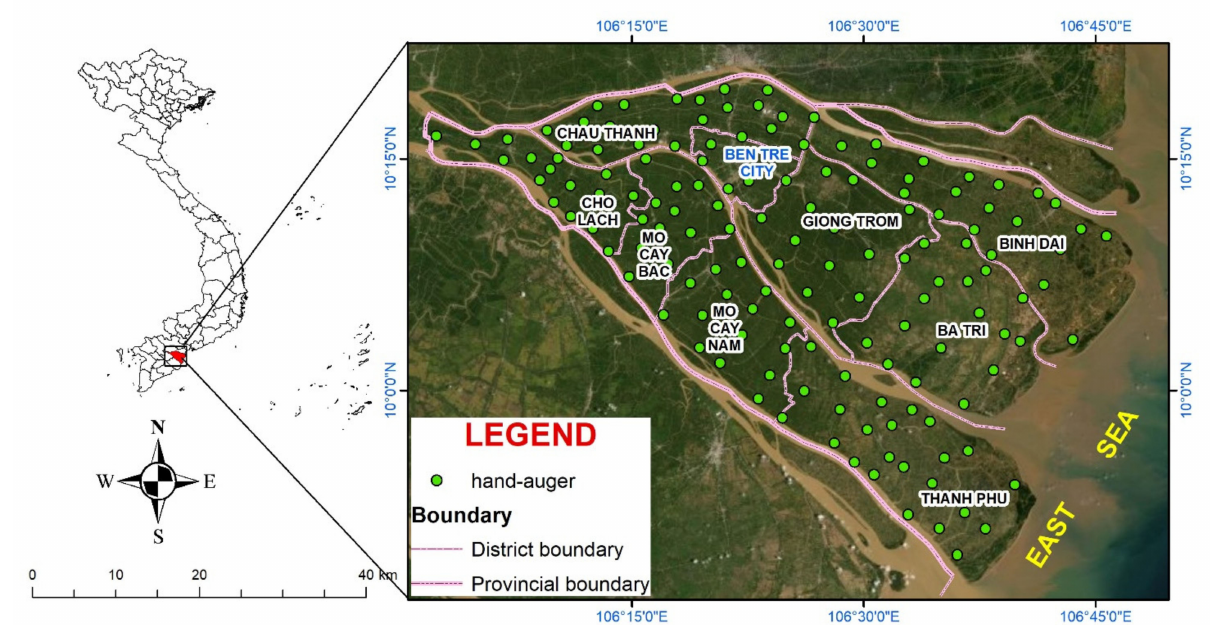
Figure 1. The study area and location of 150 hand-auger